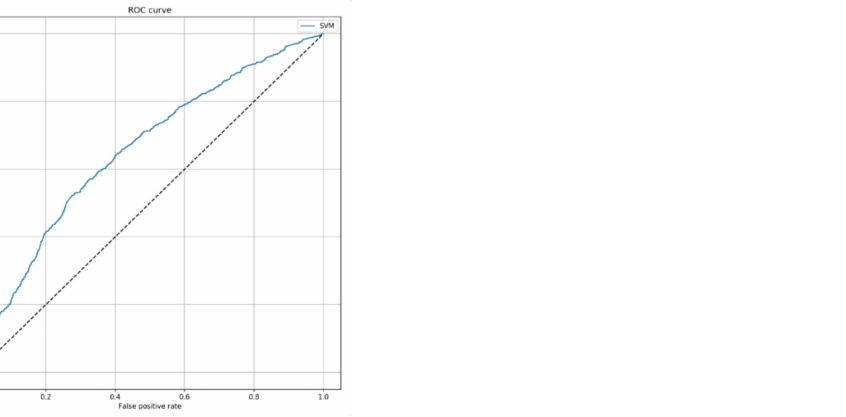
Figure 4. ROC curve of SVM algorithm predicting 7-day mortality, by excluding SAPS II score. This curve shows the predictive performance of the SVM algorithm including sex, patient’s origin, type of ICU admission, non-surgical treatment for acute coronary disease, surgical intervention, presence of invasive devices at ICU admission, trauma, impaired immunity, antibiotic therapy in 48 h before or after ICU admission. The parameters applied to the SVM algorithm were C = 2 and γ =